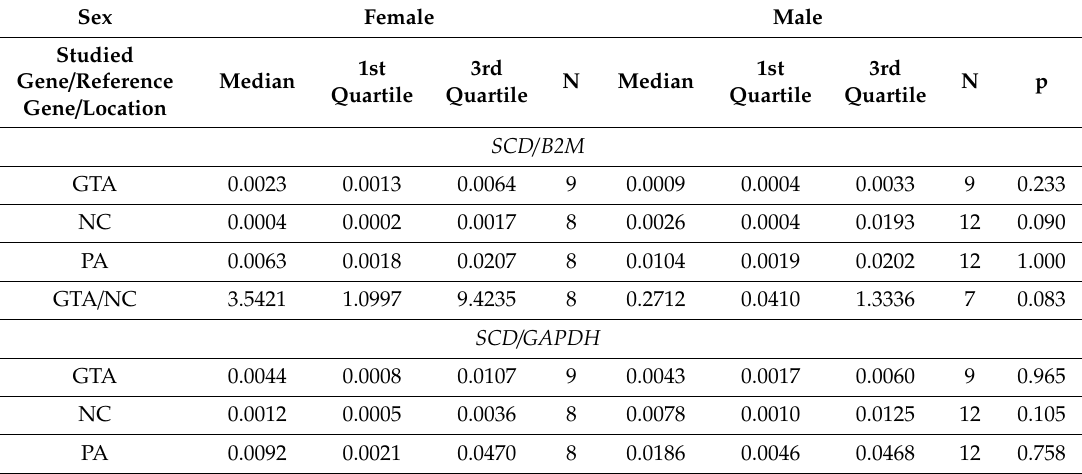
Table 5. mRNA expression of SCD and SCD5 by